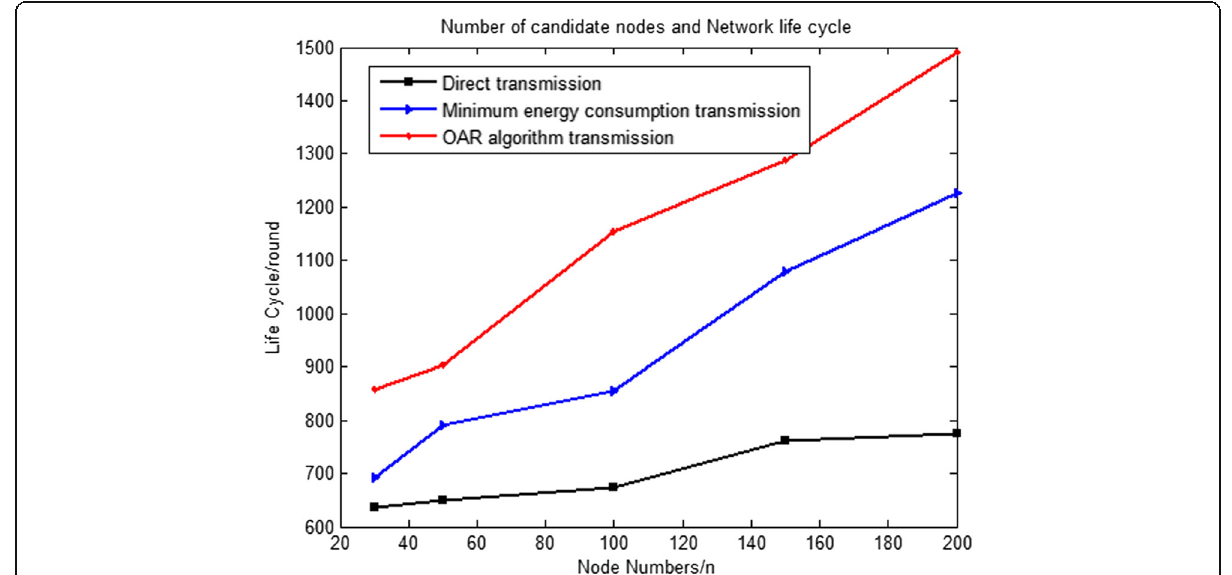
Fig. 4 Number of candidate nodes and network life cycle